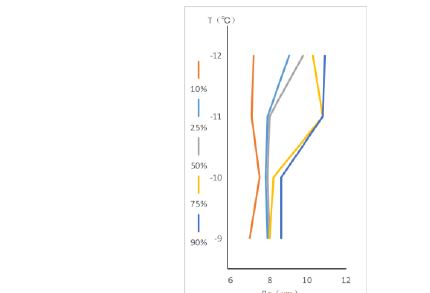
Figure 10. RGB image at 12:30 LST